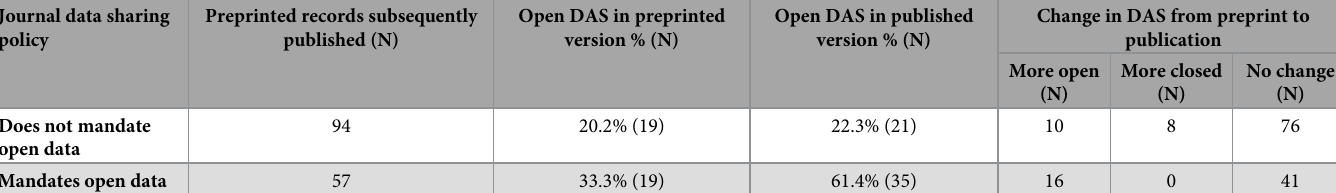
Table 2. Change in openness of data availability statements from preprint to published article, grouped by journal data-sharing policy.